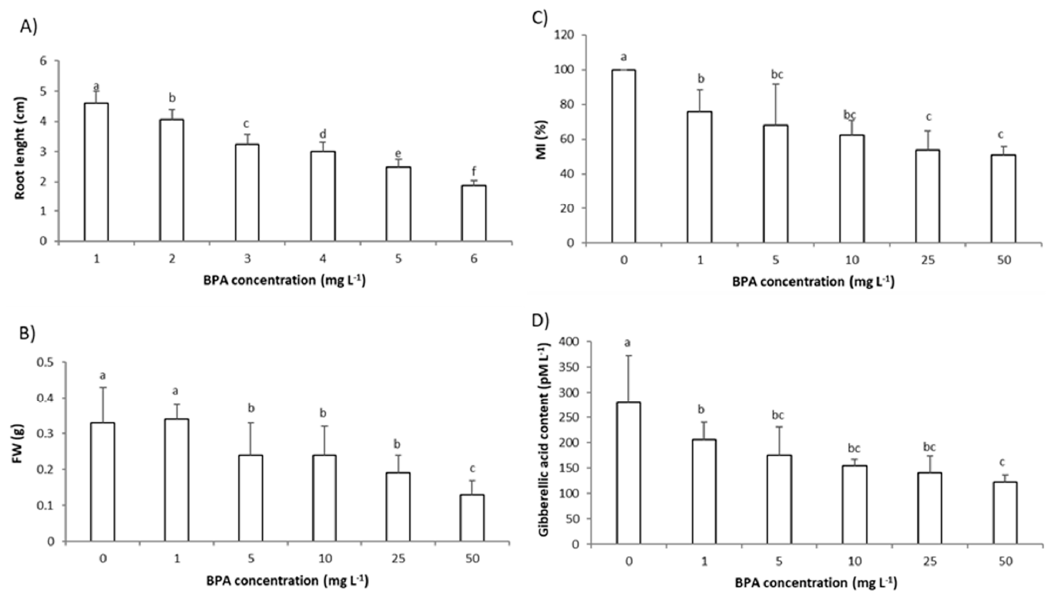
Figure 1. Parameters of root growth and level of plant hormone gibberellic acid (GA 3 ) in the root of Allium cepa after 3 days exposure to bisphenol A (BPA) in concentration range (1–50 mg L –1 ): ( A ) root length, ( B ) root fresh weight (FW), ( C ) mitotic index (MI) of root meristem cells, and ( D ) the level of GA 3 in root cells. Data are presented as mean ± SD (n = 5 replicates; MI was calculated on total of 2500 cells per treatment (of 5 replicates) and expressed as %, control is set to 100%). Different letters indicate significant difference ( p ≤ 0.05). 0—control plants, not exposed to BPA.